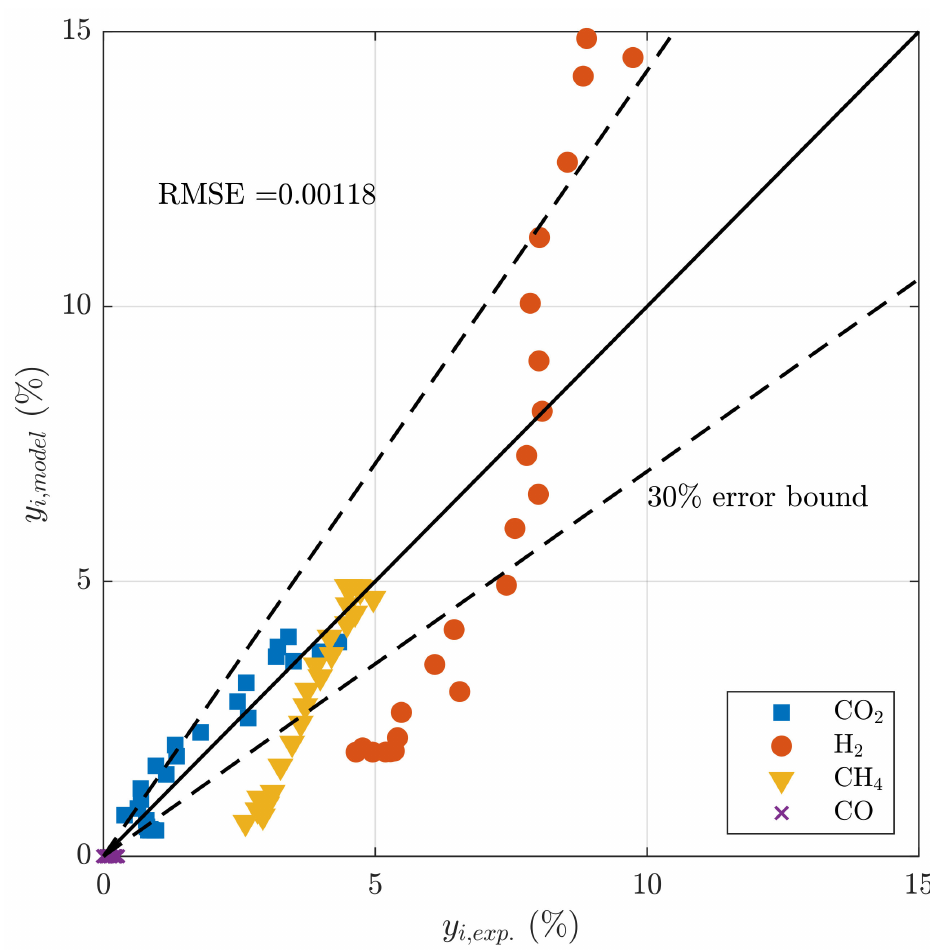
Figure 8. Parity plot between the axial experimental data ( y i,exp. ) and model prediction ( y i,model